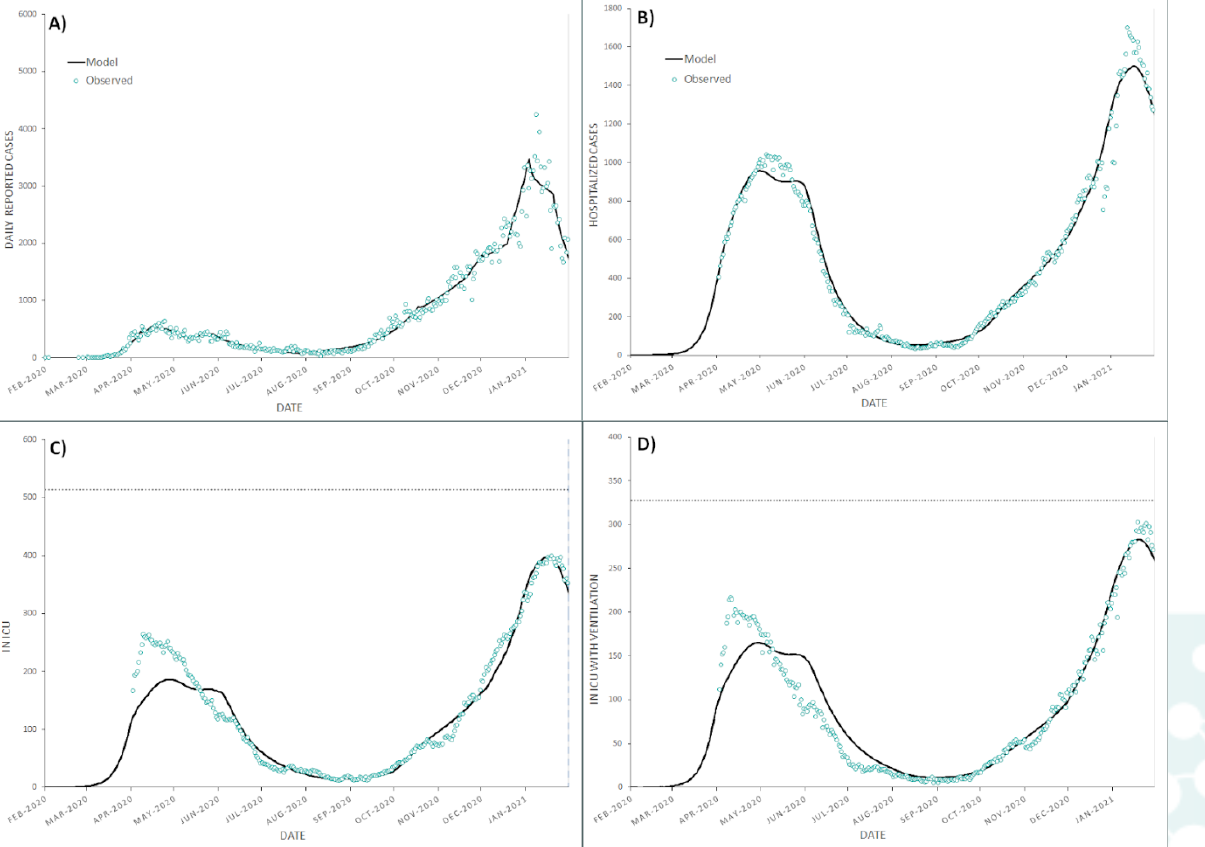
Figure A3.1: Comparison of the model outputs from the CIHI’s capacity tool and historical data from